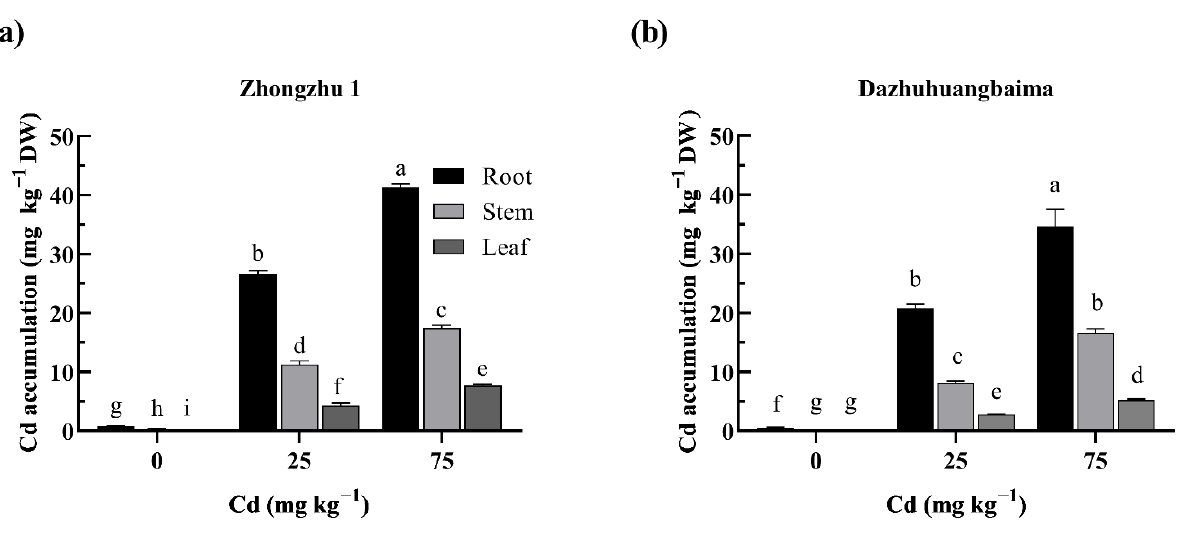
Figure 2. Cd accumulation in the roots, stems, and leaves of ‘Zhongzhu 1’ ( a ) and ‘Dazhuhuangbaima’ ( b ) under different Cd concentrations. DW, dry weight. Data represent means ± SD ( n = 3). Different letters indicate significant differences at p ≤ 0.05.